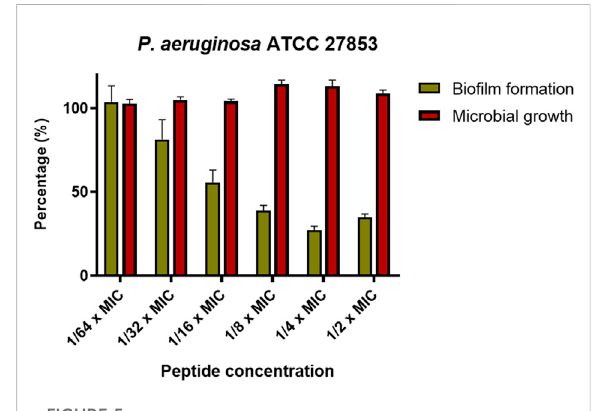
FIGURE 5 Percentage of bio fi lm biomass at different sub-MIC concentrationofKDEONWK-11(goldbars)incomparisonwiththe microbial growth (red bars). Bio fi lm biomass was quanti fi ed by CV staining,whilethemicrobialgrowthwasevaluatedbyreading the absorbance at 590 nm. Data represent the mean ± SEM of three independent experiments.